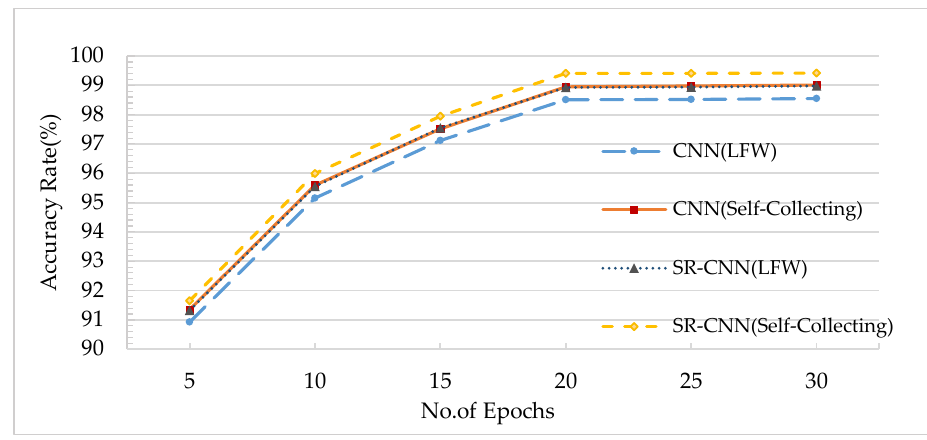
Figure 10. Comparison of accuracy for different training epochs.